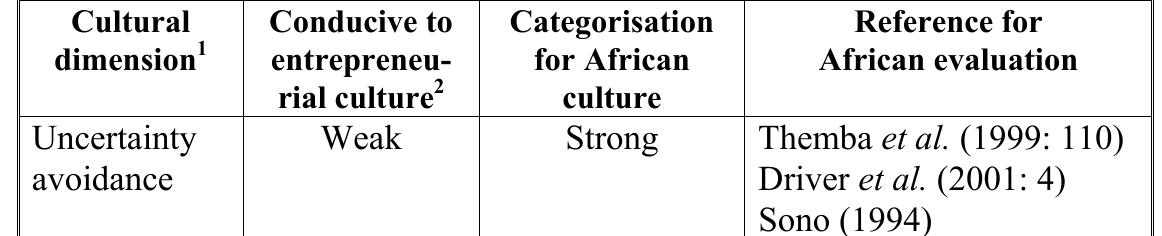
Categorising African culture for the main dimensions that may impact on entrepreneurial orientation based on Lee